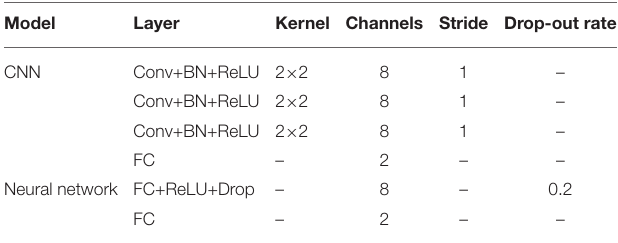
TABLE 1 | Structures of CNN and neural network: Conv is convolutional layer, BN is batch normalization layer, FC is fully connected layer, and Drop is drop-out layer. Model